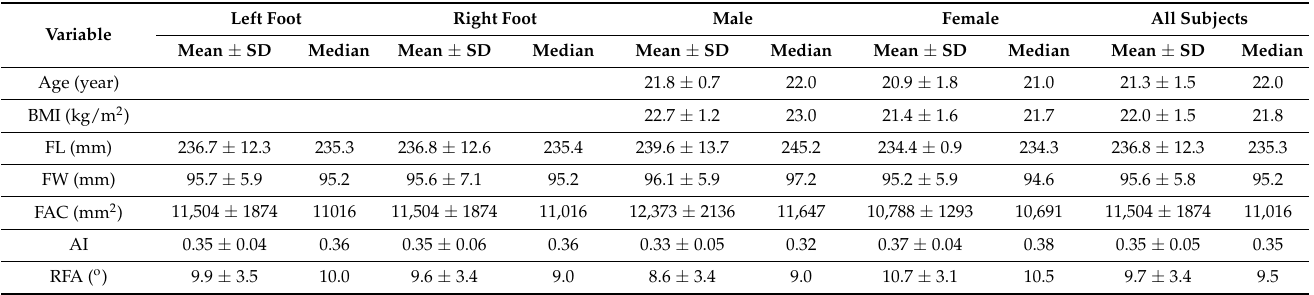
Table 1. Description of the 31 subjects according to footprint and RFA measurements